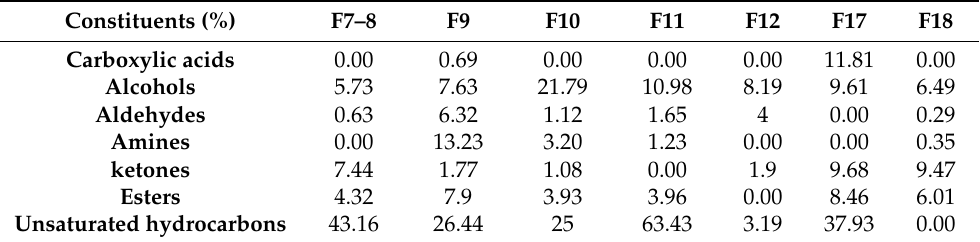
Figure 4. Inhibition of mycelial growth of Pythium ultimum in the presence of purified fractions